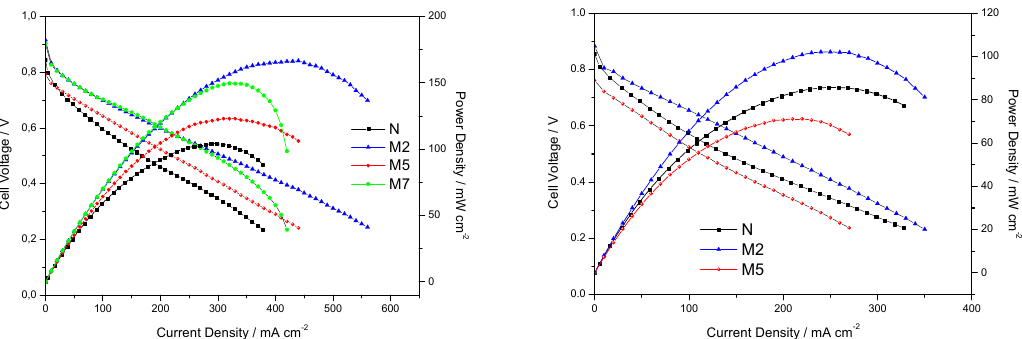
Figure 5. Fuel cell performances under 31% RH and at T = 80 °C ( on the left ) or at T= 110 °C ( on the right ).